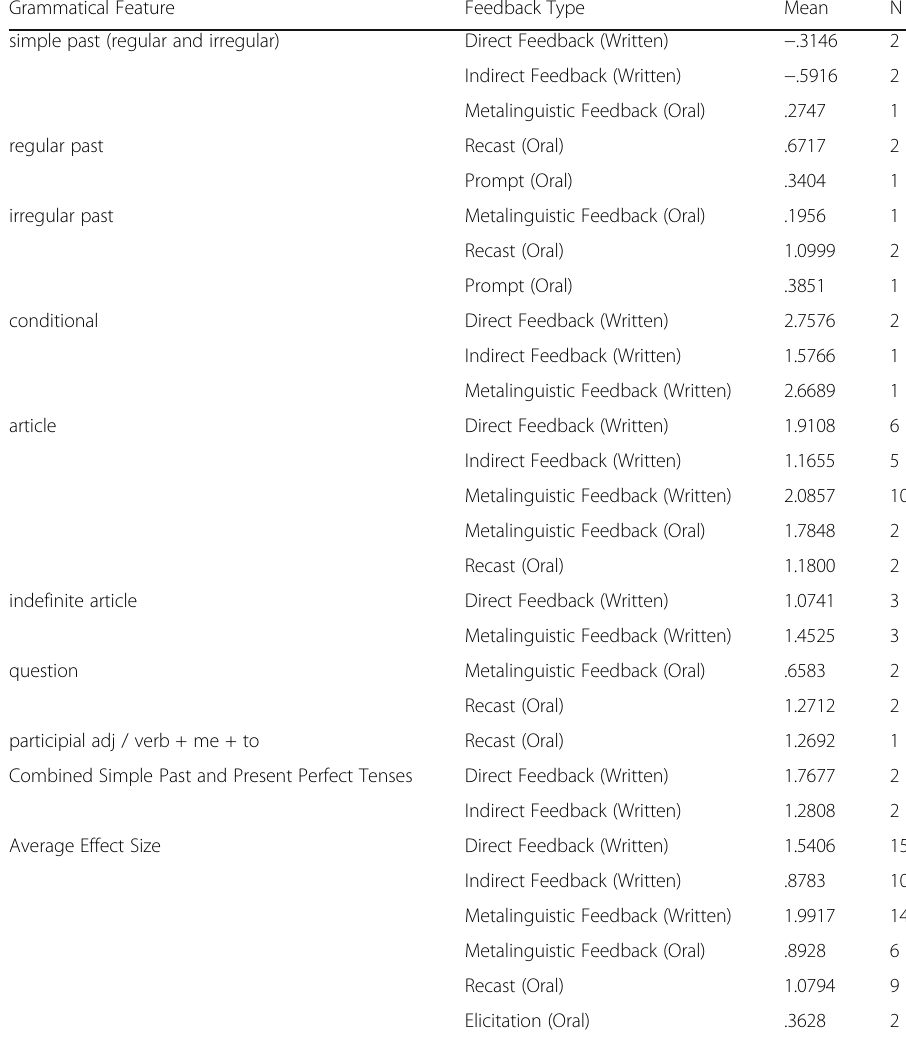
Table 3 Feedback Types by Grammatical